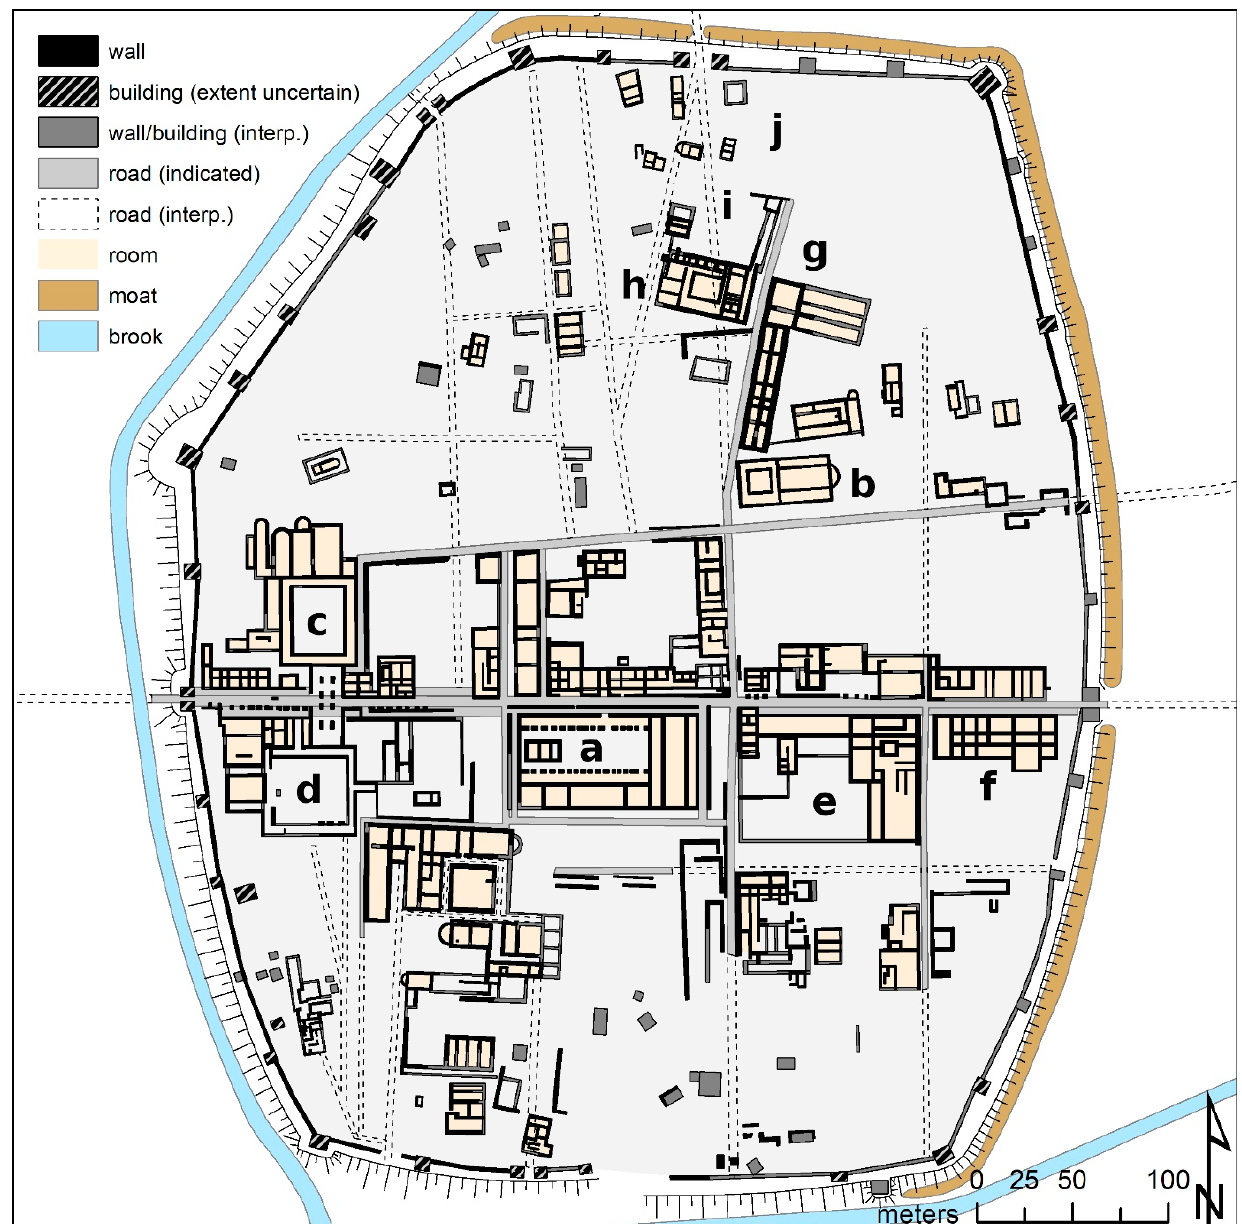
Figure 18. Idealized interpretative map of the town with the forum ( a ), the basilica excavated by Grbi ć in 1935 ( b ), two large courtyards ( c , d ), an insula also partly excavated in 1935 ( e ), suspected tabernae at the east gate ( f ), possible early christian buildings ( g , h ) that superimpose an older road ( i ), as well as several smaller individual buildings in the north ( j ).